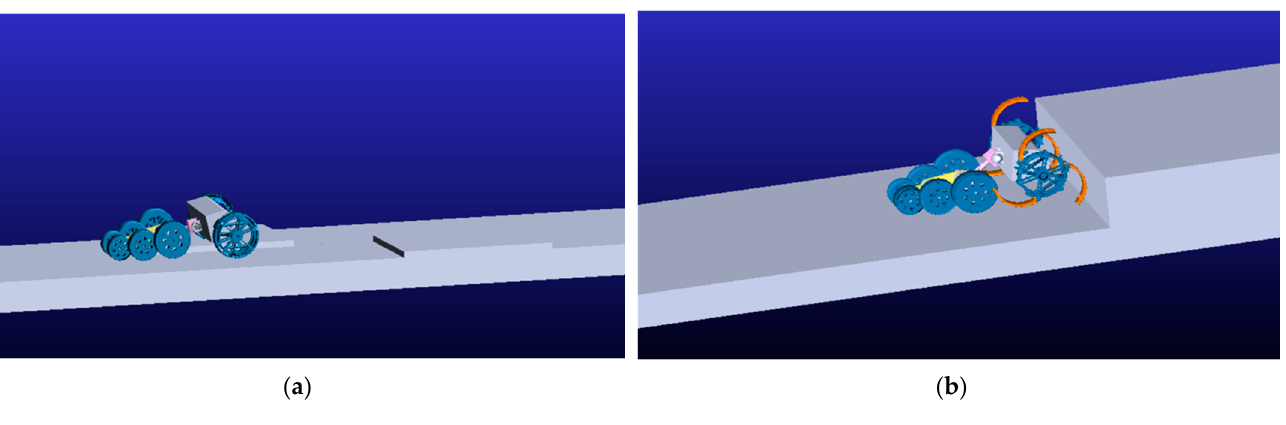
Figure 19. Simulation result of crossing a complex road surface. ( a ) Robot centroid displacement and velocity; ( b ) robot centroid acceleration.